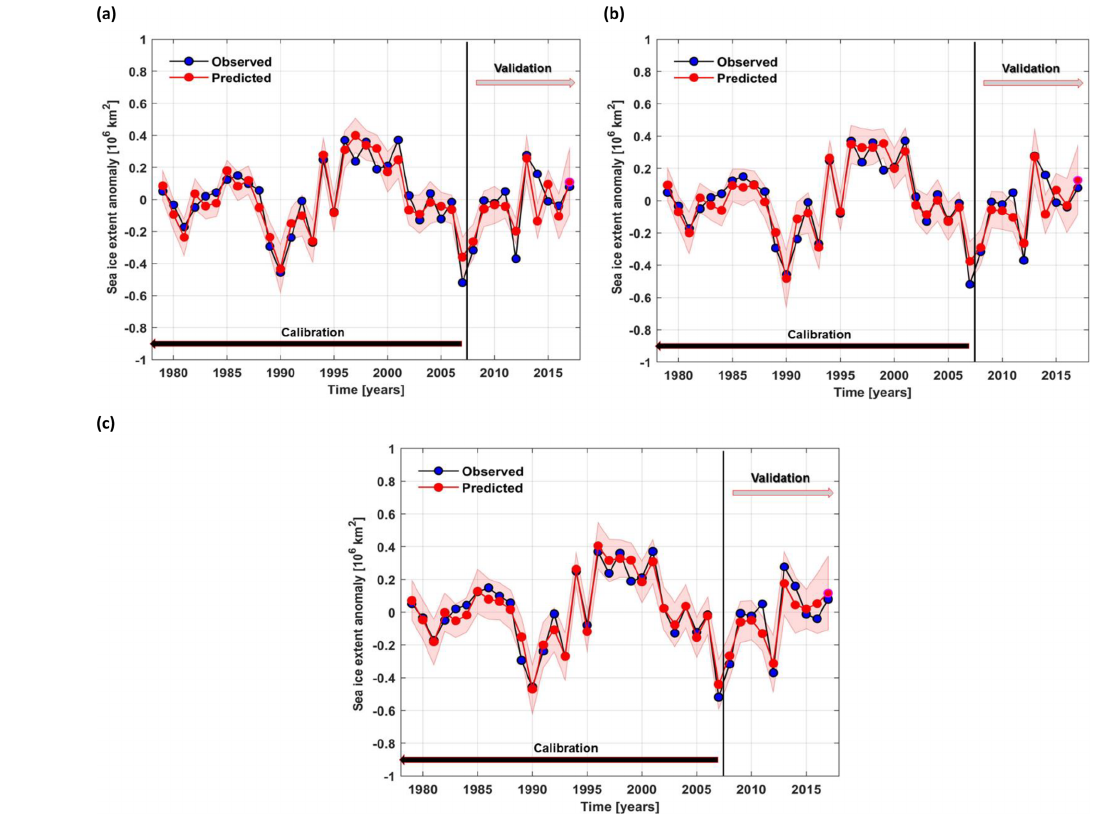
Figure 8. Observed (black) and predicted (red) East Siberian sea ice extent detrended anomalies over the period 1979–2017 based on (a) May, (b) June and (c) July predictors from the stable regions. The shaded area represents the 95% uncertainty bounds.